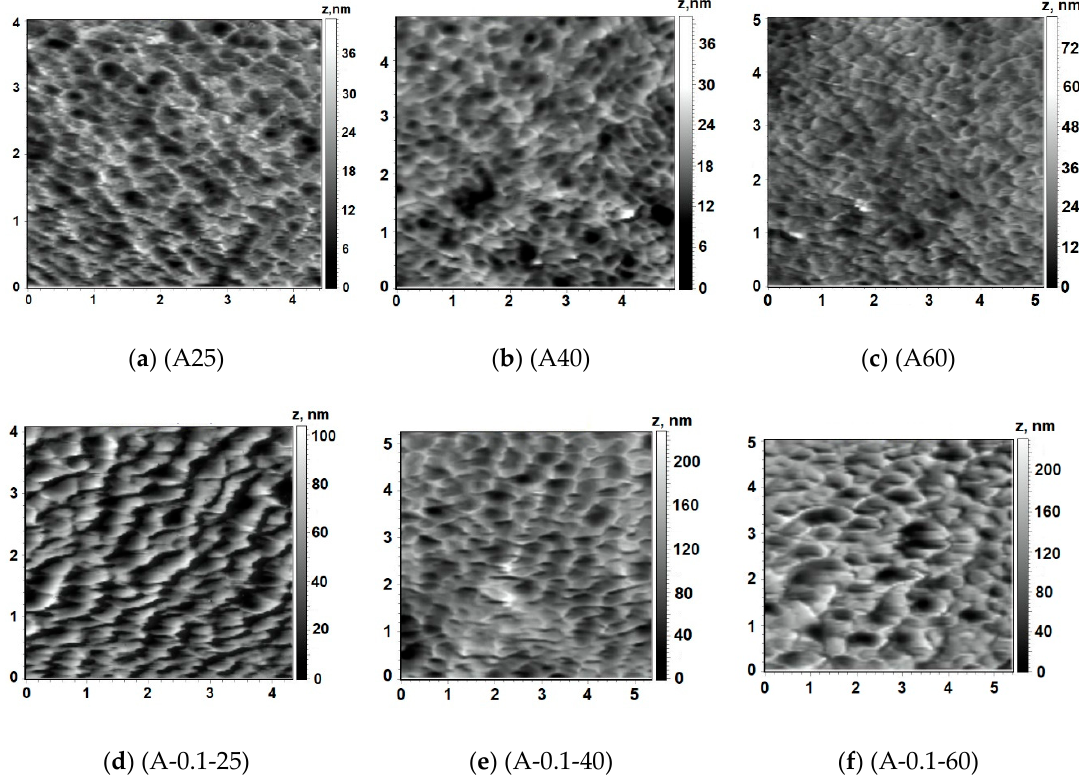
Figure 8. AFM images of the skin layer surface of PSF membranes, PASA concentration in the coagulant: ( a – c ) 0; ( d – f ) 0.1. Coagulation bath temperature, °C: ( a , d ) 25; ( b , e ) 40; ( c , f ) 60. Table 2. Parameters of surface roughness determined by atomic force microscopy